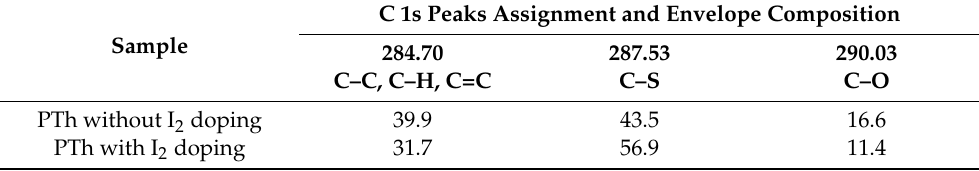
Table 2. Peak assignment (BE, eV) and envelope composition (%, total = 100) of various C 1s core level spectra of PTh films observed in XPS in Figure